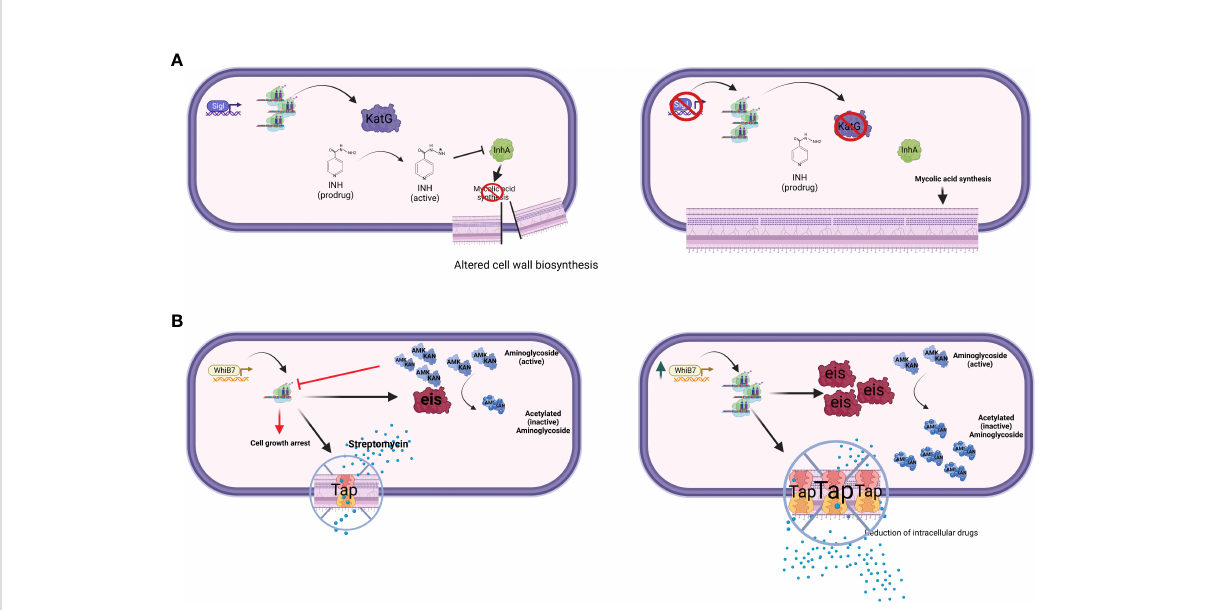
FIGURE 1 The fi gure schematizes two major drug-resistance mechanisms mediated by transcriptional factors. (A) Transcriptional factor down-regulation. The ECF sigma factor SigI controls the transcription of katG; m utant strains lacking SigI are more resistant to INH (Lee et al., 2012). (B) Transcriptional factor over-expression. WhiB7 regulon contains key genes involved in DR, such as rv2416c ( eis ) linked to low-level KAN and AMK resistance, and rv1258c ( tap ) whose overexpression is linked to low-level STR resistance (Reeves et al., 2013). Point mutations in tap, V219A and S292L, have been associated with resistance to PZA, INH, and STR (Liu et al., 2019). Created with